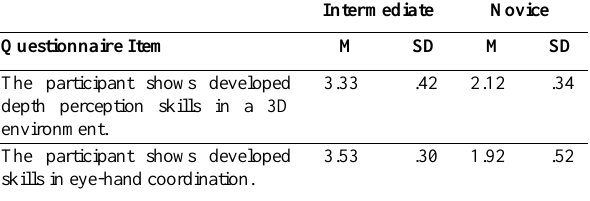
Table 7. Descriptive Results for Questionnaire Analysis of the